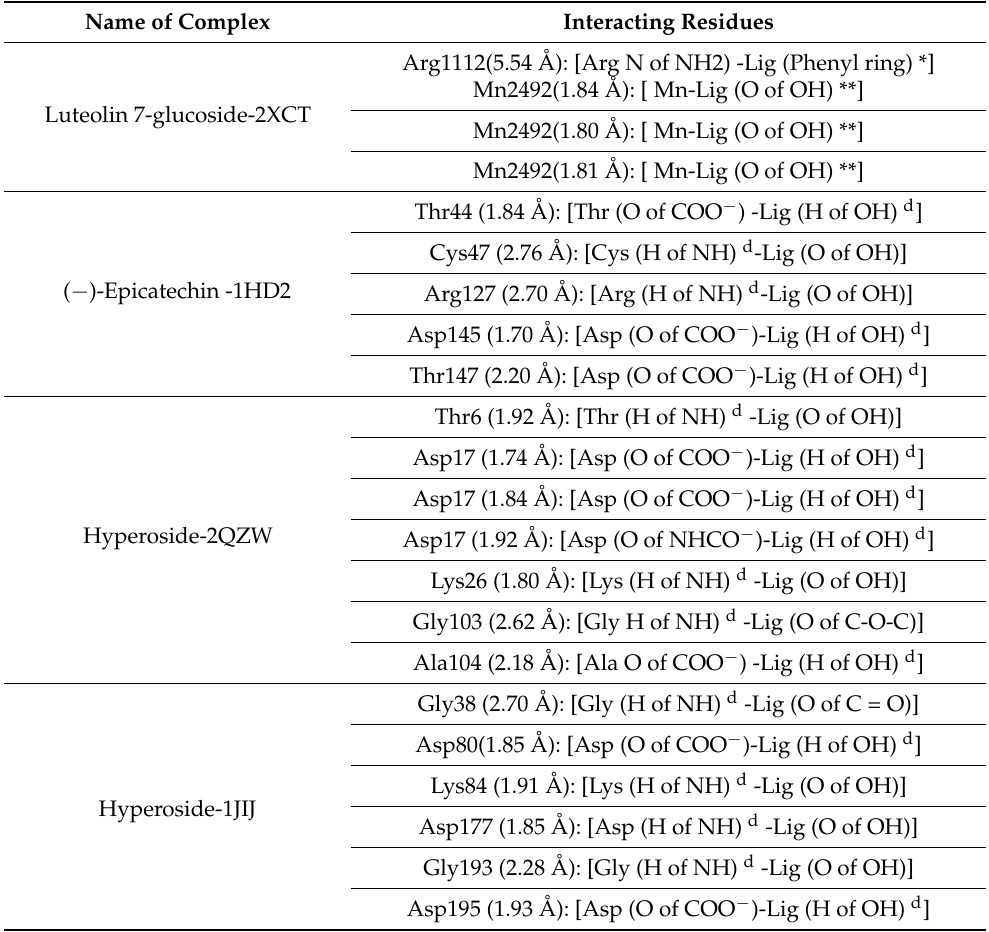
Table 5. Interacting active site residues of receptors with the best phyto-compounds identified in D. flabellifolia hydroalcoholic